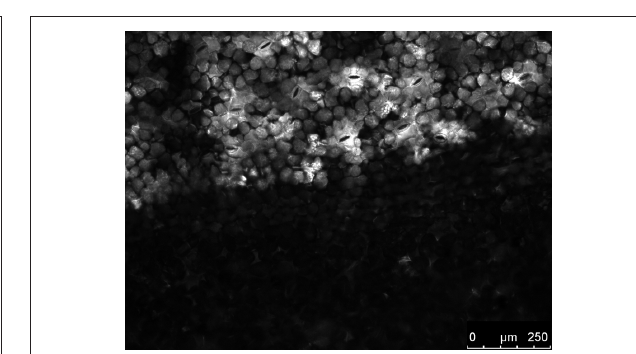
Figure A3 | NaCl does not increase noise signal intensity. Adaxial leaf face. Overlay of a pseudo-green fluorescence image at ex 495 nm, a pseudo-red fluorescence image ex at 440 nm and the corresponding bright-field image (gray-scaled). The upper light-gray area was loaded with 50 mM NaCl (not with Oregon Green). After the NaCl solution had been loaded directly into the leaf apoplast, no additional unspecific noise signals were detected after illumination with ex 495 and ex 440 nm. Noise signals, if present, would have appeared in pseudo-green or pseudo-red within the light-gray area of the